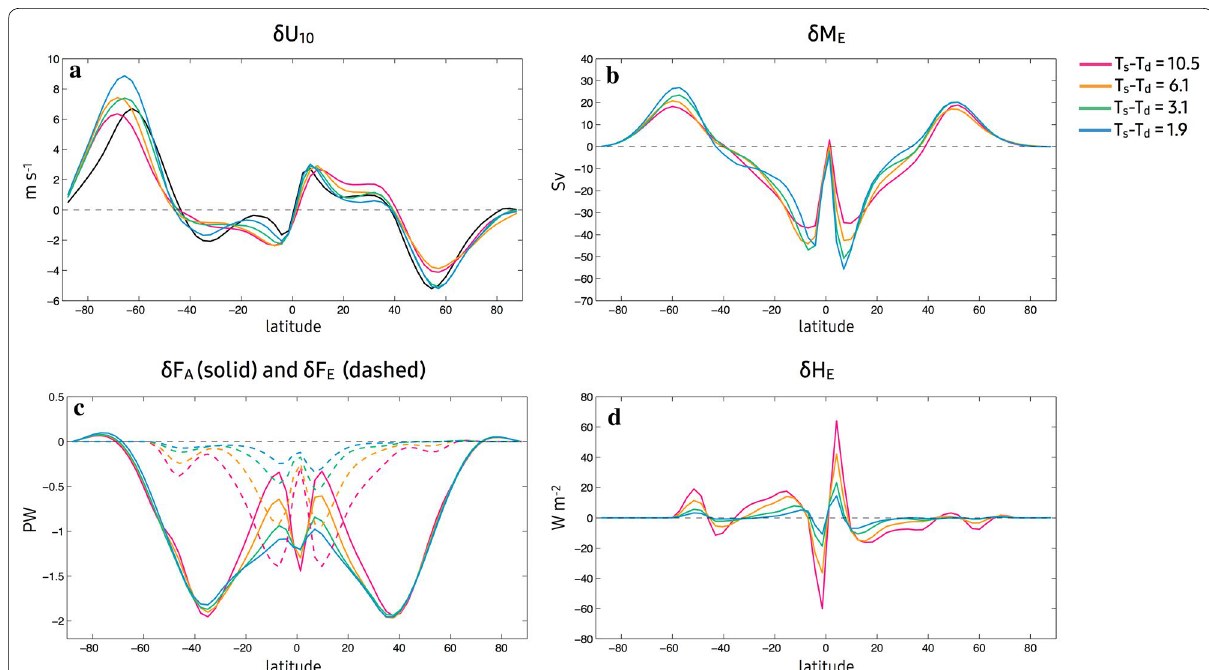
Fig. 4 Zonal-mean changes in a the zonal wind at 10 m in m s − 1 , b the meridional Ekman mass transport δM E in Sv, c the meridional energy transport by the atmosphere δF A (solid) and by the Ekman flow δF E (dashed) in PW, and d the Ekman-induced heating δH E in W m − 2 (solid) in the experiments with extratropical perturbations with F S0 4.6 =